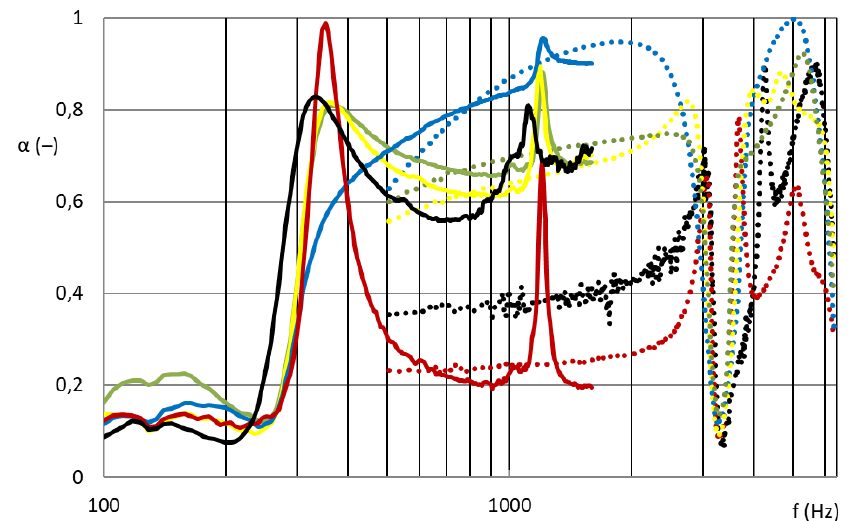
Figure 9. Sound absorption coefficient depending on sound frequency (100–6400 Hz). Solid curve: 100 mm diameter samples for frequency range 100–1600 Hz; dotted curve: 29 mm diameter samples for frequency range 500–6400 Hz. Grid M2 with a nanofibrous membrane: blue: PVDF5; yellow: PVDF10; green: PVDF16; red: PVDF45; black: PA6022.